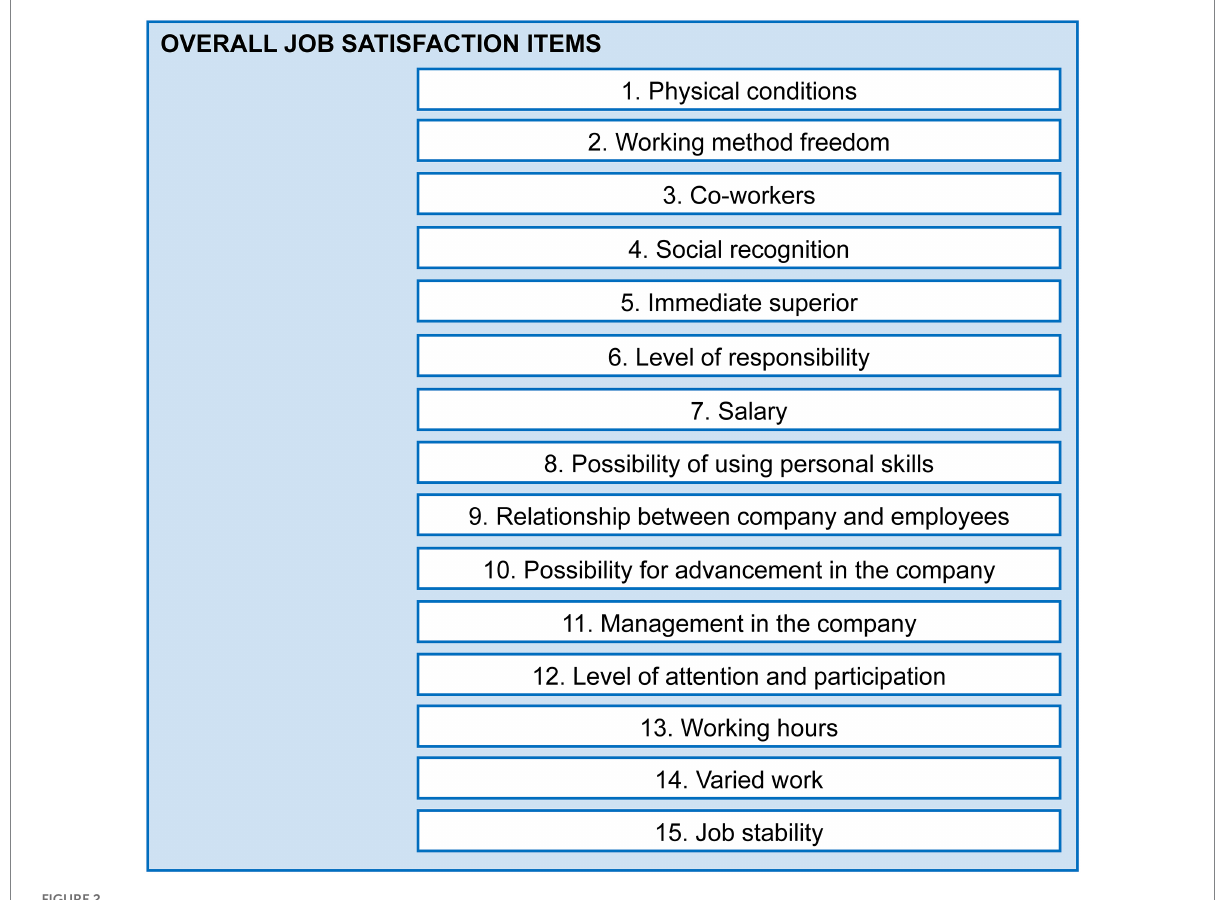
FIGURE 2 Description of the job satisfaction items (Overall).